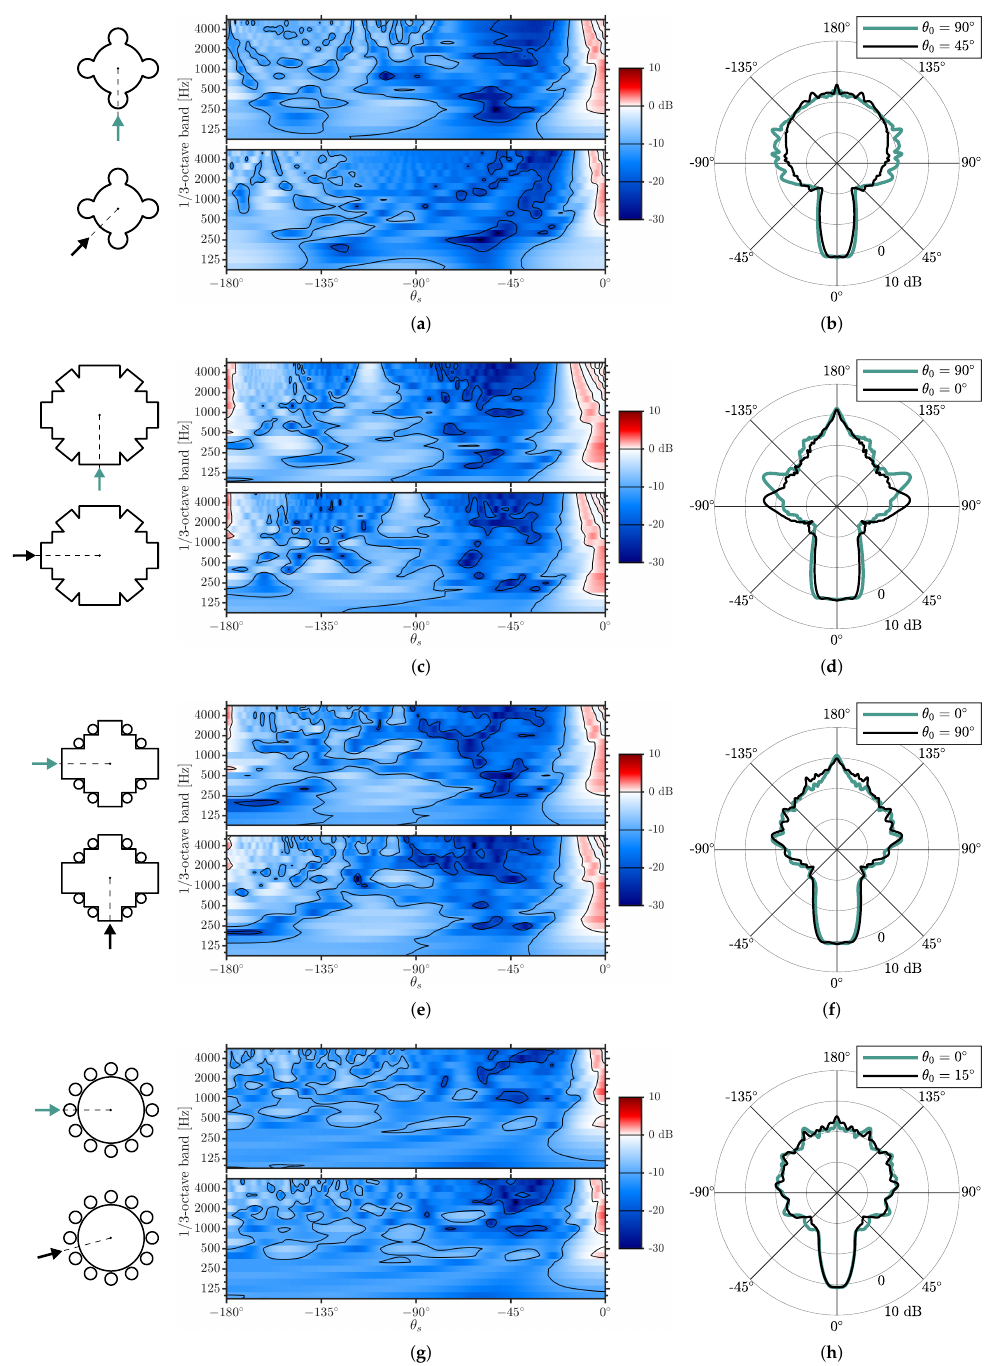
Figure 9. RDLDs for N2 ( a , b ), C1 ( c , d ), C2 ( e , f ), and N3 ( g,h ) for different plane wave incidence angles θ 0 as functions of the scattering angle θ s : One-third octave bands ( a , c , e , g ) and overall ( b , d , f , h ) results. The receiver positions are reported in Table 1.